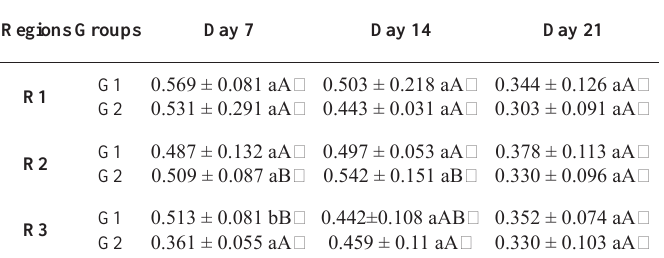
no difference occurred on day 21. TABLE 4 – Mean values (±SD) of the measurements (mm) of the growth plate, by groups (G1: irradiated, G2: control) and evaluation